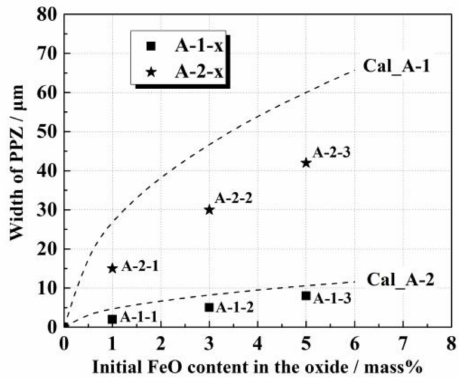
Figure 12. Experimental and calculated change of PPZ width with initial FeO content in the oxide of A-1- x and A-2- x diffusion couples after the isothermal heating for 10